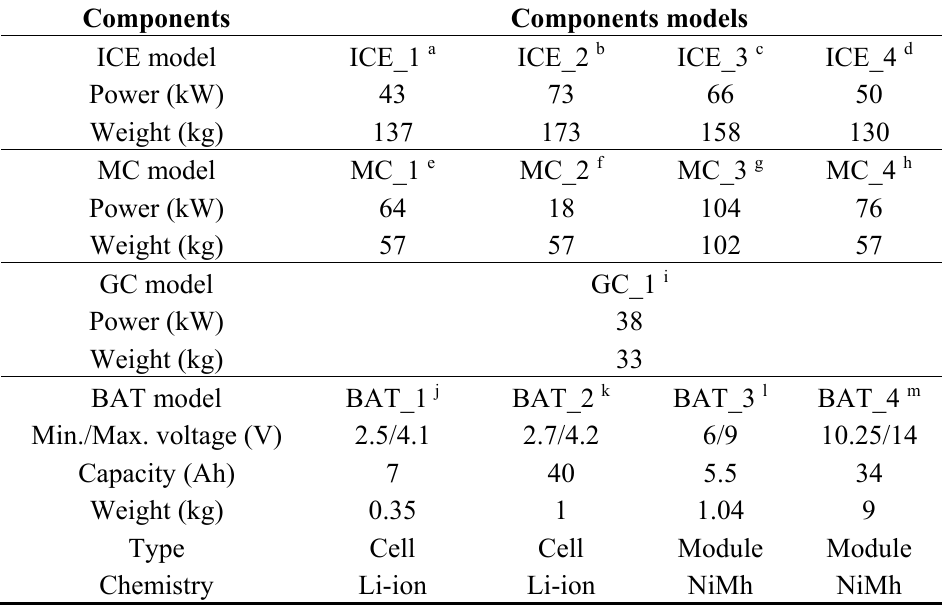
Table 7. Powertrain components